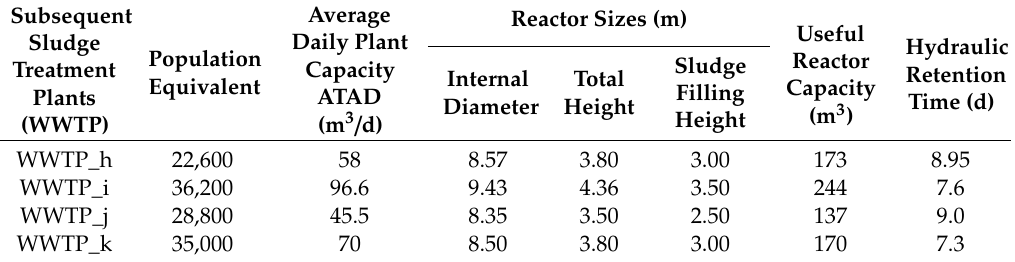
Table 2. Technical and technological parameters of three-reactor